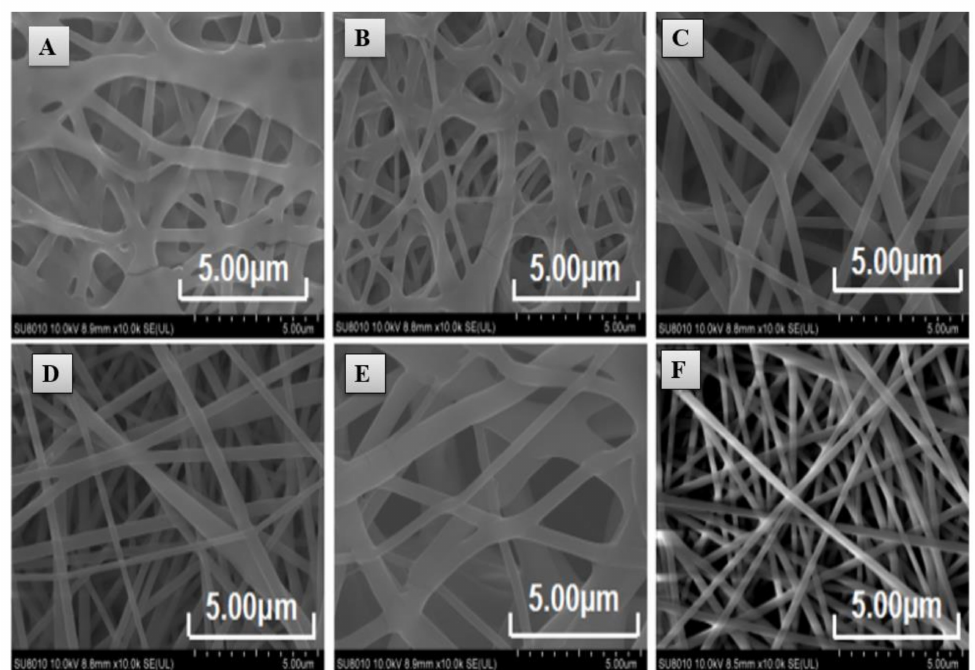
Figure 9. SEM photographs of crosslinking nanofibrous films obtained with the various spinning solutions with and without CEO: ( A ) CPVA, ( B ) CPVA-CEO, ( C ) CPVA-0.5CEO- β -CD, ( D ) CPVA-